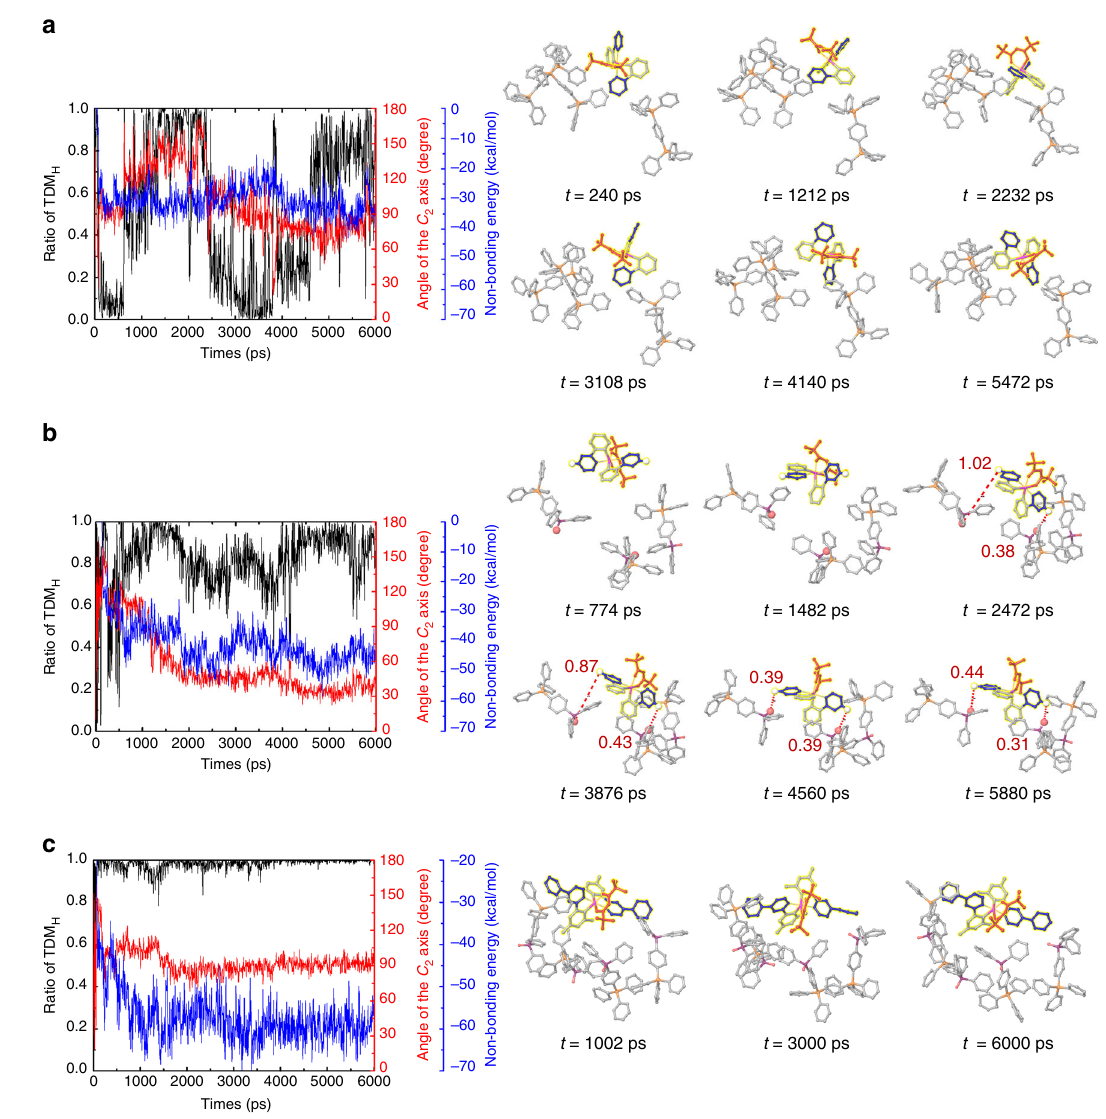
Fig. 6 Representative con fi gurations during deposition. Snapshots of local con fi gurations and time-dependent trajectories of the EDO, angle of the C 2 axis, and non-bonded interaction energy up to 6 ns are depicted together. The ancillary ligand and pyridine rings of the phosphors at the octahedral sites are colored by red and blue , respectively. a Ir(ppy) 2 tmd deposited onto the UGH-2 layer has a continuous rotation and the occasionally observed perpendicular alignment of pyridines with respect to the substrate results in vertical EDO. b Ir(ppy) 2 tmd anchors on the surface of TSPO1 layer by the local quadrupole – dipole interaction between the two nearest host molecules located at both sides. The hydrogen atoms at both pyridines of Ir(ppy) 2 tmd and the oxygen atoms of TSPO1 connected by a broken line were the plausible binding sites. The distances between the two atoms ( broken lines ) are getting closer until around 0.4 nm as the time increases and a host-dopant – host pseudo complex is formed with the parallel alignment of pyridines with respect to the substrate. c Ir(dmppy-ph) 2 tmd deposited onto the TSPO1 layer are less mobile than Ir(ppy) 2 tmd with the low non-bonded interaction by the con fi guration of large dispersion force energy along the direction of